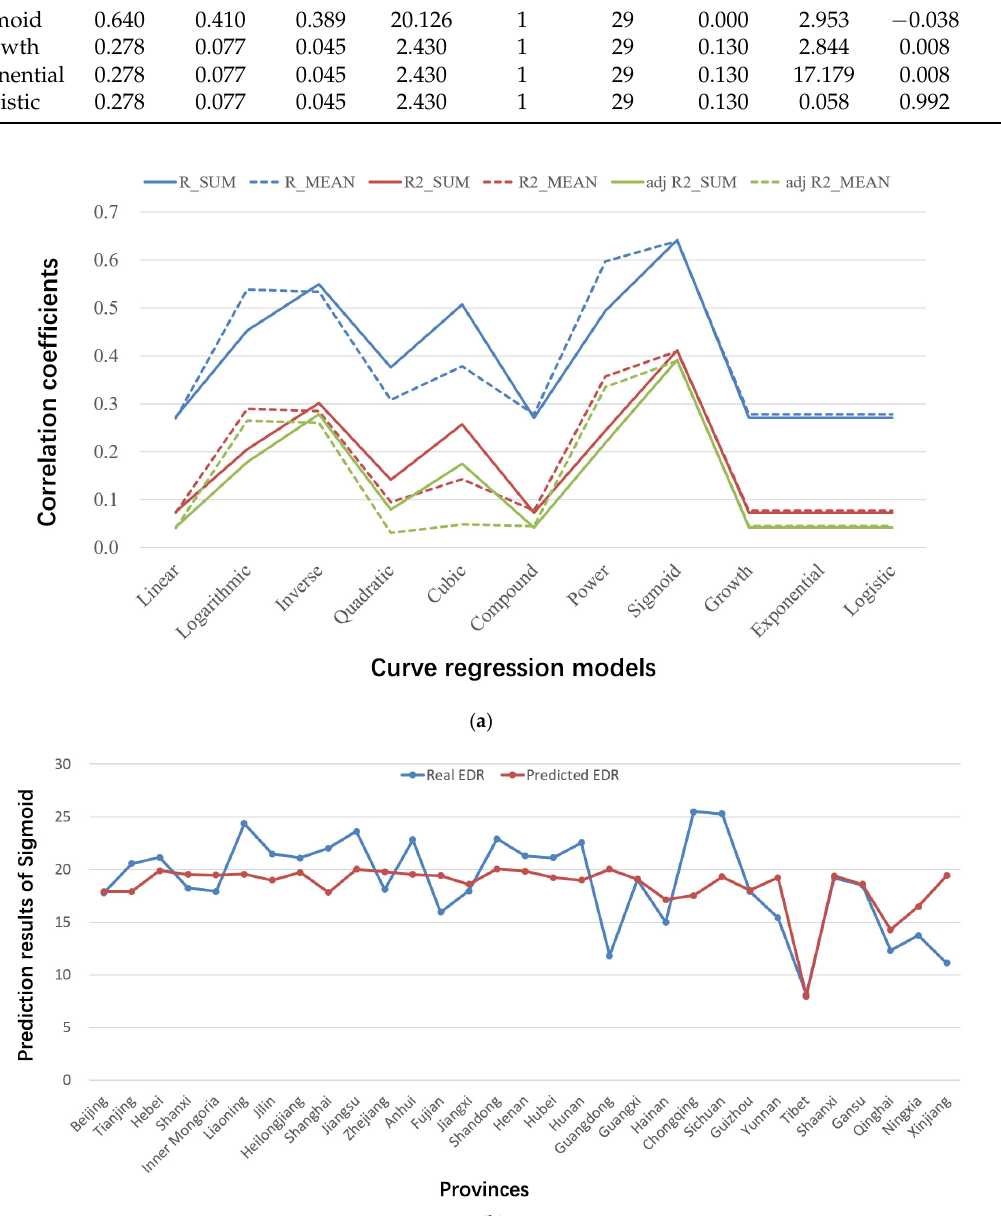
Figure A2. Fitting effects of different models. ( a ) Correlation coefficients; ( b ) Prediction results of Sigmoid.